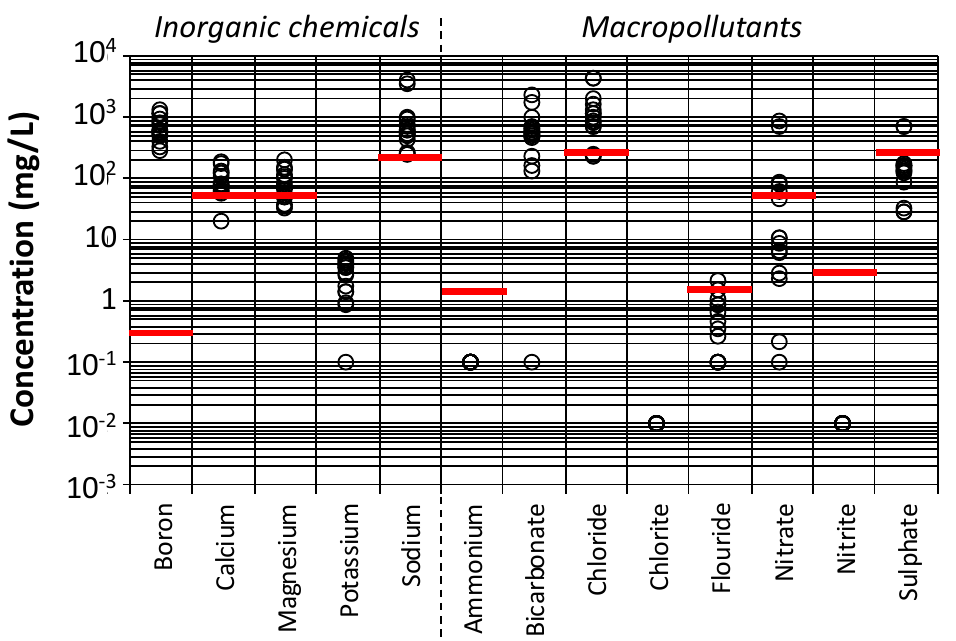
Figure 7. Observed concentrations of macropollutants and heavy metals (circle) in groundwater in the reviewed studies referring to Mozambique and the corresponding limits set by local legislation (red line) for drinking water. Data from: [27].